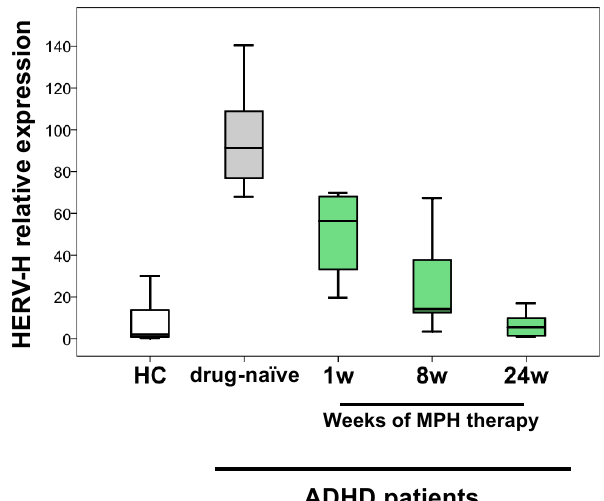
Figure 1. HERV-H expression in peripheral blood mononuclear cells (PBMCs) from attention deficit hyperactivity disorder (ADHD) patients at different times of methylphenidate (MPH) therapy. HERV-H relative expression was evaluated in fresh PBMCs from seven drug-naïve ADHD patients (grey box plot) and after 1, 8, and 24 weeks of MPH therapy (green box plots) and compared to that obtained in fresh PBMCs from 12 healthy controls (HC), age- and sex-matched (white box plot).